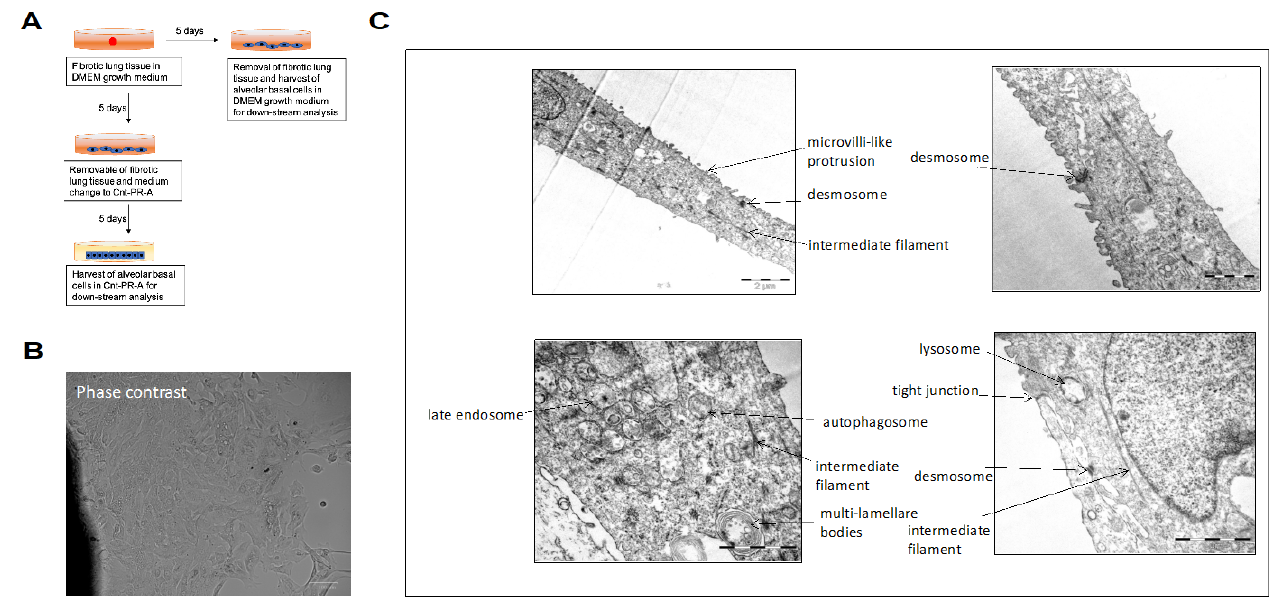
Figure 1. Morphology of alveolar basal cells cultured in DMEM growth medium. Experimental design of the study ( A ). Basal-like cells were cultured in DMEM growth medium for 5 days and then analyzed by ( B ) phase contrast microscopy, or ( C ) electron